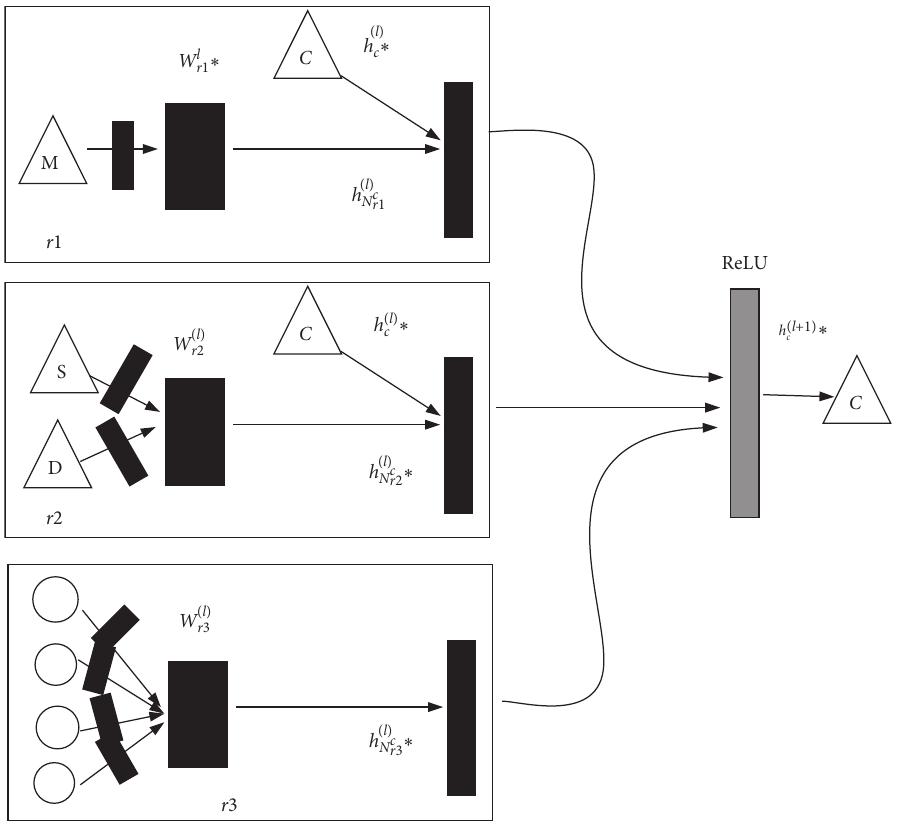
Figure 2: Process of H-GCN